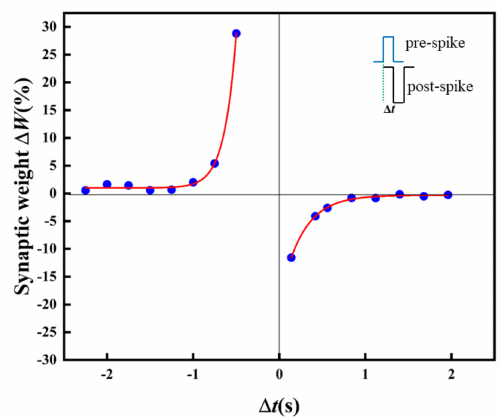
Figure 9. STDP of the Au/CsPbI 3 /ITO artificial synapse. The relative change of the synaptic weight ( ∆ W ) versus the relative spike timing ( ∆ t ); ∆ t = t post − t pre . The blue dots are the measured data, and the red solid line is the result of fitting by the Origin